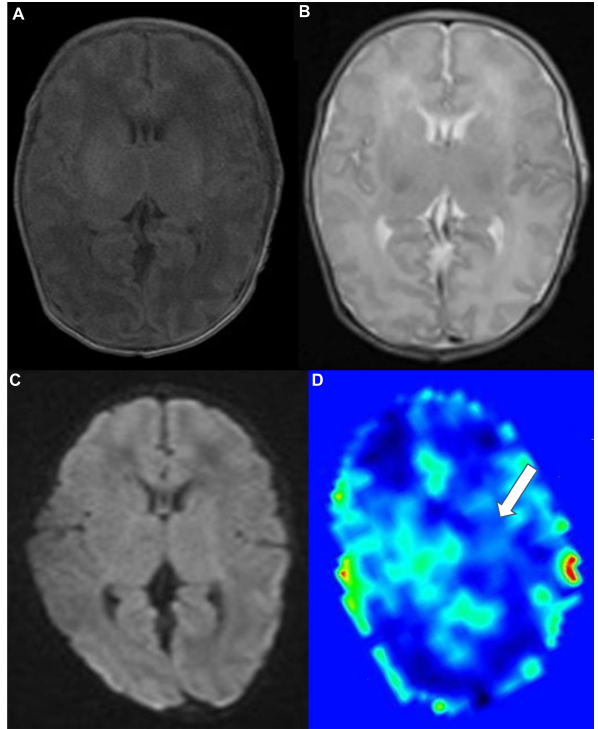
Fig. 4. Images of a 10-day old female HIE infant (with a history of in- trauterine infection and neonatal asphyxia). There was no signal ab- normality on T1WI (A), T2WI (B) and DWI images (C). (D) The perfusion was reduced at the left basal ganglia region on CBF maps